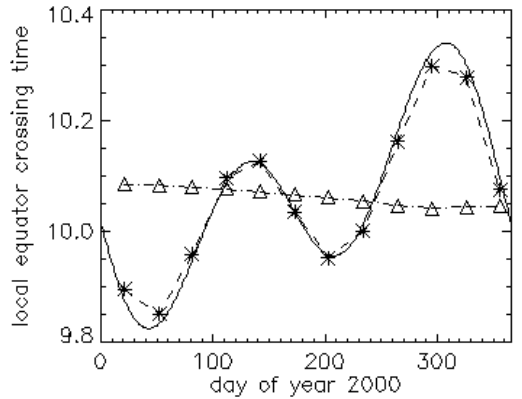
Figure 5. Variation of LECT determined for each 21 st day of a month, calculated by means of STK software of acquisition facility for mean (triangles) and real (asterisks, connected by dashed line) Sun of descending node of Landsat 7 for year 2000. t LEC_0 (solid